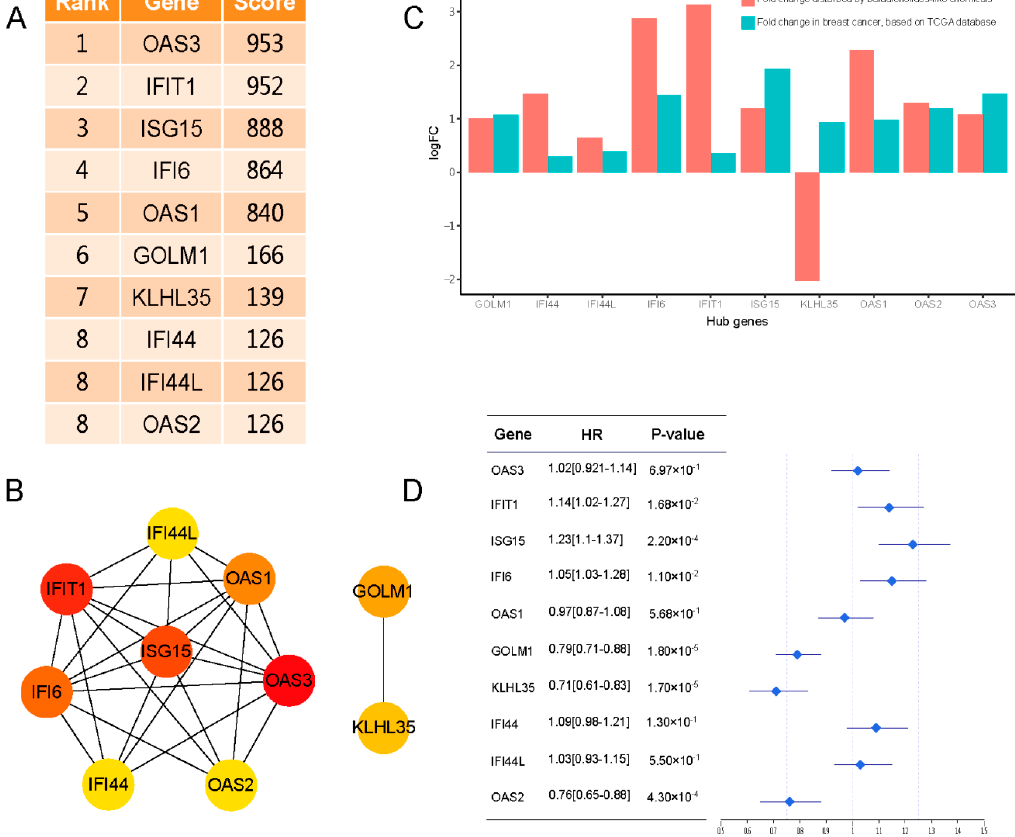
Figure 9. The 10 hub genes and their correlation with the total survival probability in breast cancer. ( A ) The 10 hub genes and their MCC (Maximal clique centrality) score. ( B ) The network of hub genes. ( C ) The expression correlation with breast cancer, validated by the TCGA database. ( D ) The total survival probability correlation with breast cancer, validated by the Kaplan-Meier (KM) plotter database.